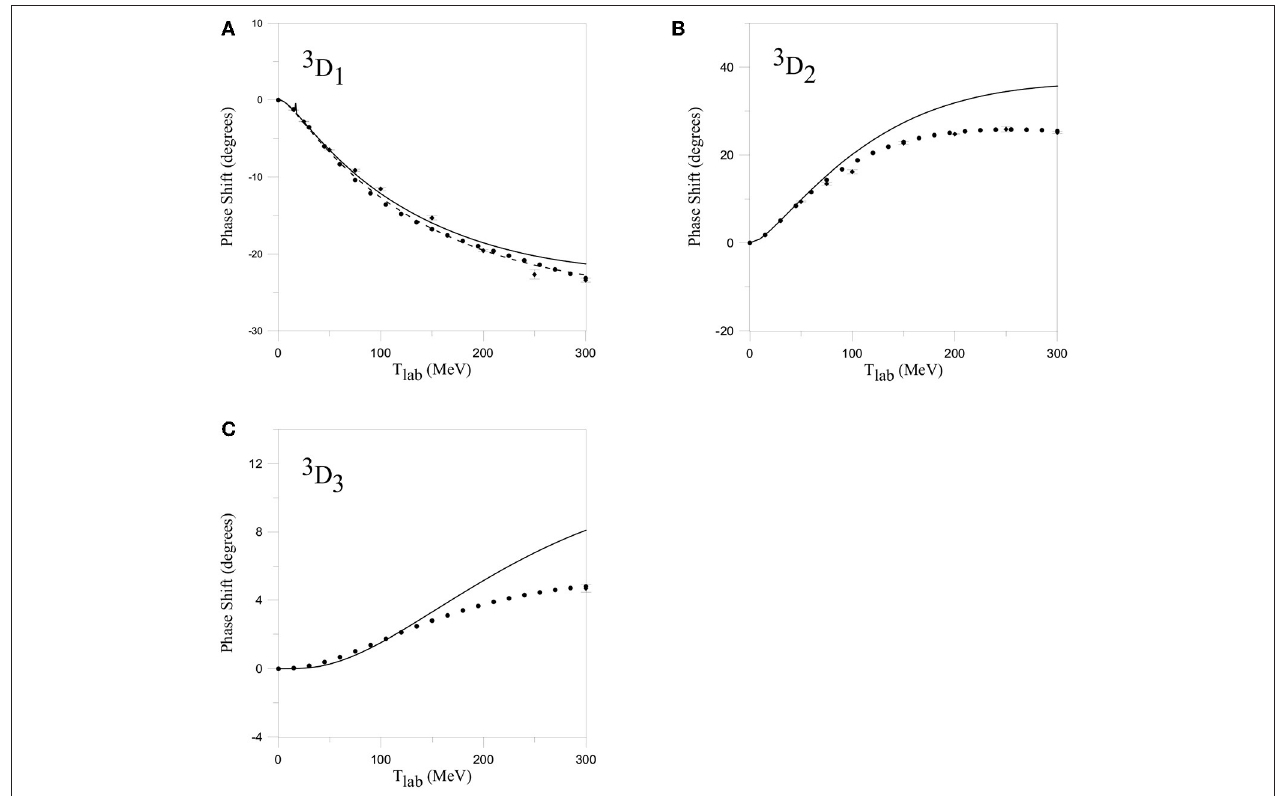
FIGURE 8 | NN 3 D J phase-shifts. (A) Lines are labeled as in Figure 4B . (B,C) Solid line corresponds to the result with NN channels only. Reprinted figure with permission from Entem et al. [ 52] Copyright (2000) by the American Physical